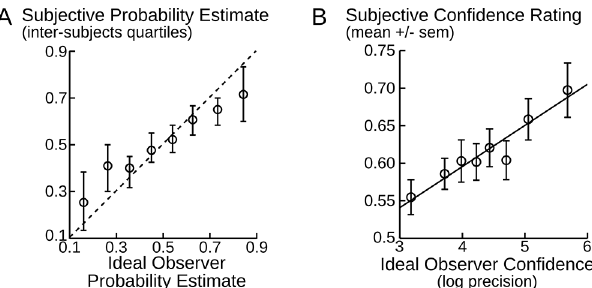
Fig 4. Accuracy of probability estimates and confidence. (A) Estimated probability that the next stimulus is A plotted against the Ideal Observer estimate. These probability estimates correspond to the transition probabilities p(A|A) or p(A|B), depending on whether the previous stimulus was A or B; both are pooled together. The dotted line corresponds to the identity. Error-bars and dots are the 75%, 50% and 25% percentiles across subjects. (B) Subjective confidence plotted against the Ideal Observer confidence. The steps of the subjective confidence scale were coded such that 0 corresponds to 'Not at all sure' and 1 to 'completely sure'. The Ideal Observer confidence is summarized as the log precision,-log( σ 2 ), with σ ² the variance of the estimated transition probability distribution. The fitted line is the average of the linear fits performed at the subject level. In A & B, equally-filled data bins were formed along the horizontal axis because the sequence of stimuli (and hence, estimates that can be inferred) differed across participants. Bins are used only for visualization and not for data